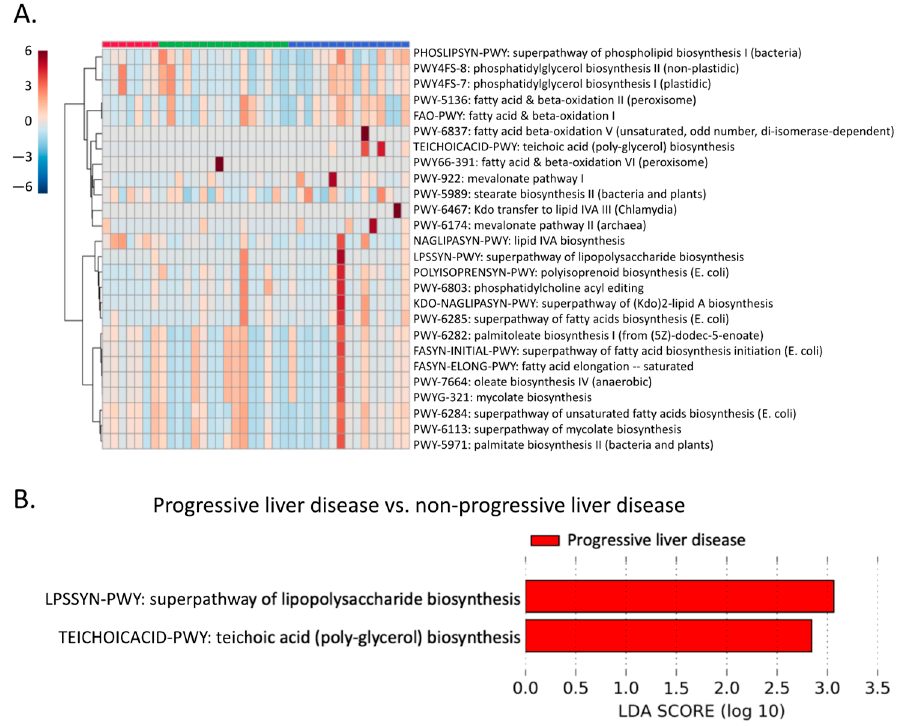
Figure 6. Microbial lipid metabolism. ( A ) Fecal microbial lipid pathways detected using metagenomic sequencing of fecal DNA. ( B ) Enriched fecal microbial lipid pathways in patients with progressive liver disease compared with non-progressive liver disease. LDA: Linear Discriminant Anal- ysis.